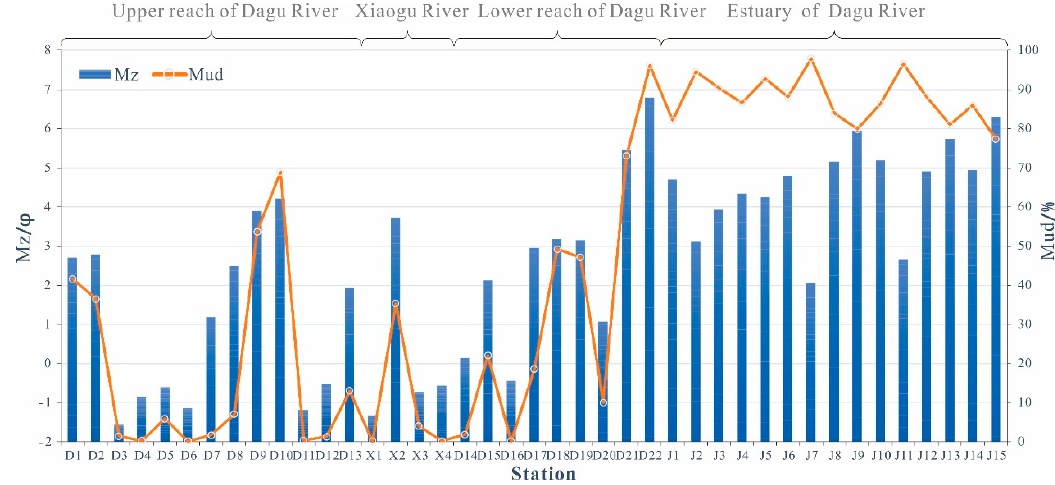
Figure 2. Content changes of mean grain size (Mz: Φ ) and mud component (Mud: %) in the river and estuary sediments. The left axis represents the mean grain size value (blue bar chart), and the right axis represents the mud content (red line chart).